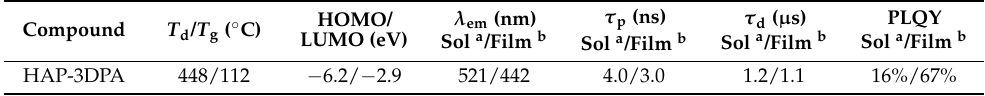
Figure 2. ( a ) The thermo-gravimetric analysis (TGA) and differential scanning calorimetry (DSC) curves of HAP-3DPA. ( b ) The HOMO energy level of HAP-3DPA determined by atmospheric ultraviolet photoelectron spectroscopy. ( c ) The PL spectrum of HAP-3DPA in a neat film. ( d ) The transient PL decay of HAP-3DPA in a neat film. Table 1. Thermal and photophysical properties of HAP-3DPA.